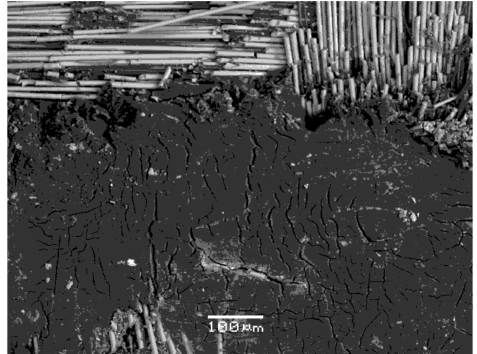
Figure 17. SEM image of the textolite surface with very strong degradation effects (150 times magnification). Strong cracking of the carbonised resin and damage to the glass fibres in the textile support is